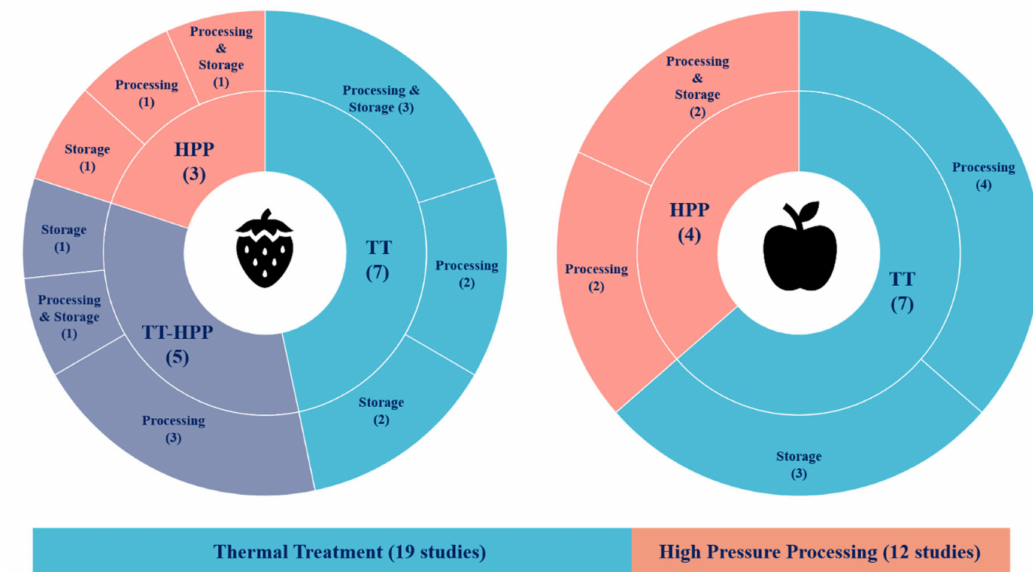
Figure 2. Overview of the studies evaluating the thermal treatment (TT) and high-pressure processing (HPP) impact and their subsequent storage on the primary polyphenols in strawberry and apple